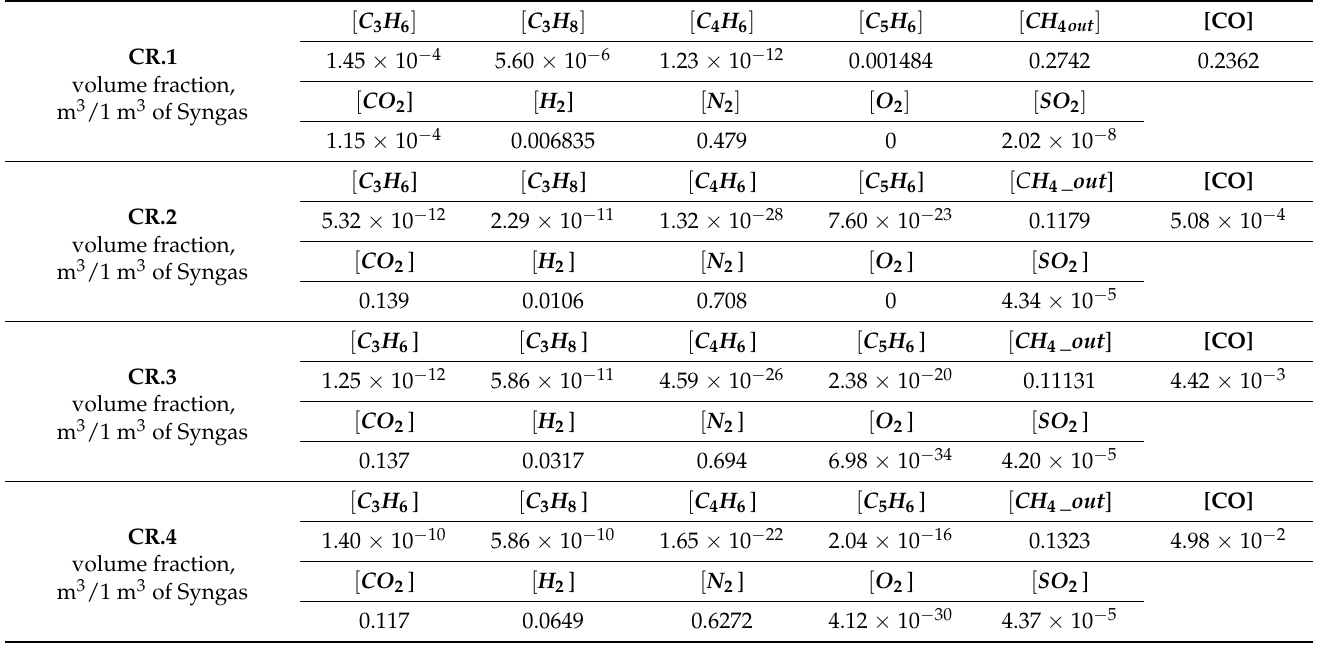
Table 8. Decision-making results: Syngas composition in volume fraction, m 3 /1 m 3 of Syngas.